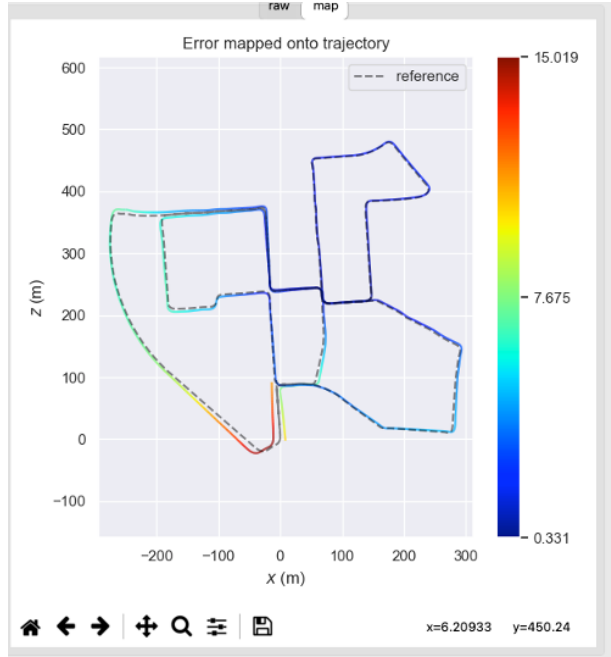
Figure 6. The whole trajectory evaluation